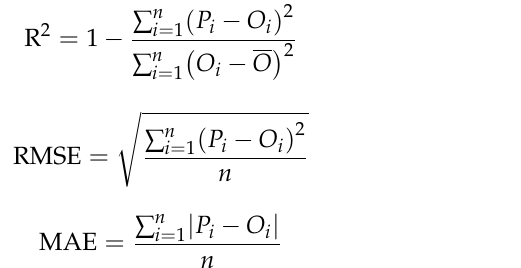
Table 2. Descriptive statistics of the original and logarithmic SOC observations .